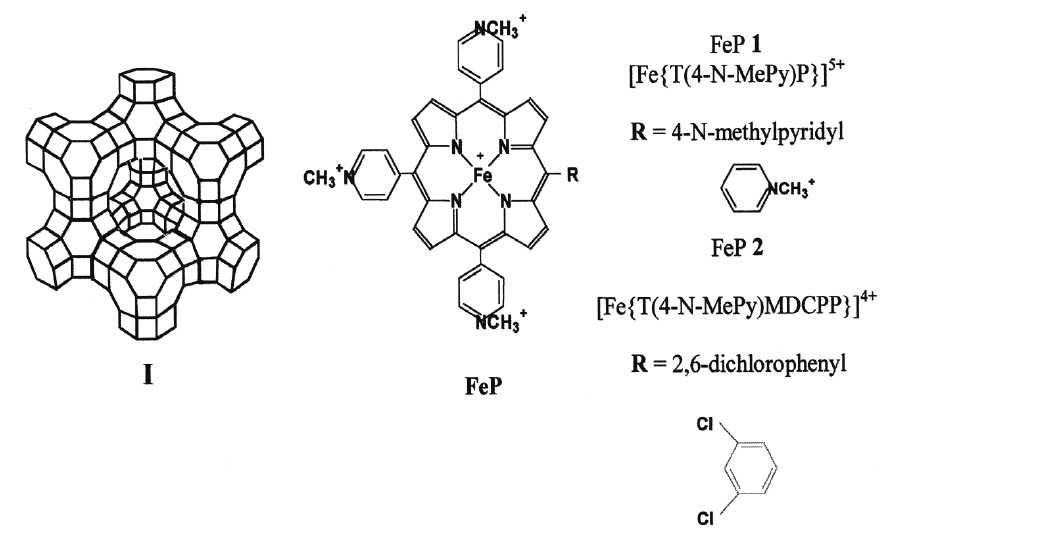
Figure 6: Encapsulation of two Fe(III) tetraphenylporphyrins into the cavities of zeolite NaX [82]. Reprinted with permission from Ref. [82]. Copyright © 2000,